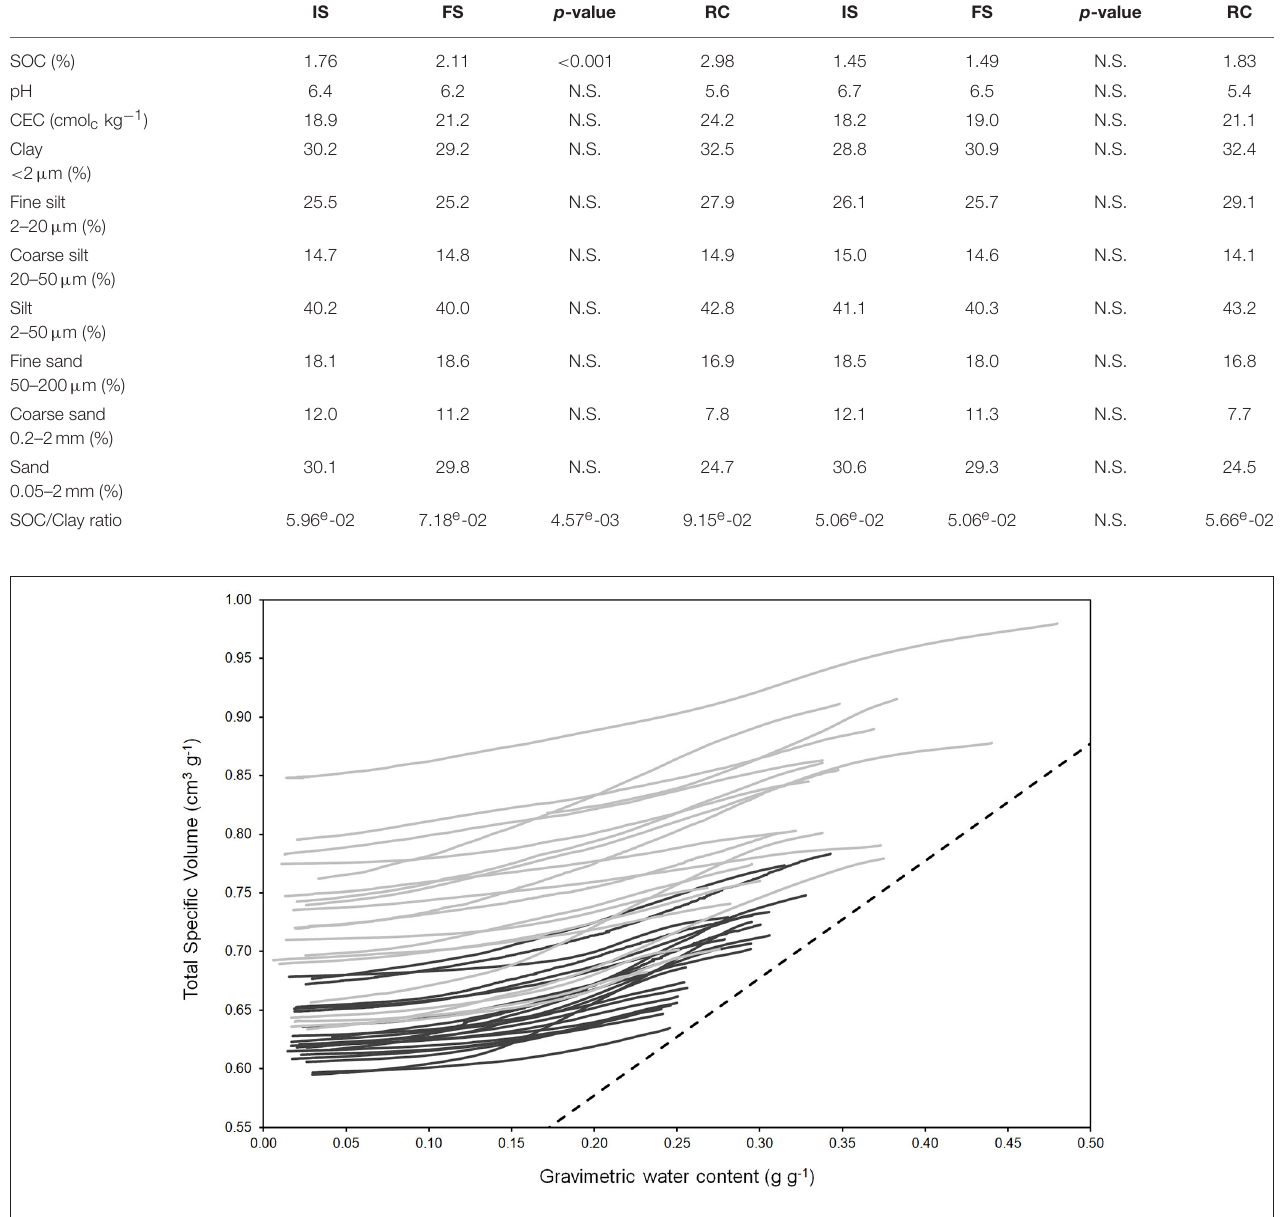
FIGURE 3 | Shrinkage curves determined on the undisturbed samples at initial (black solid) and final state (gray solid), 5–10cm